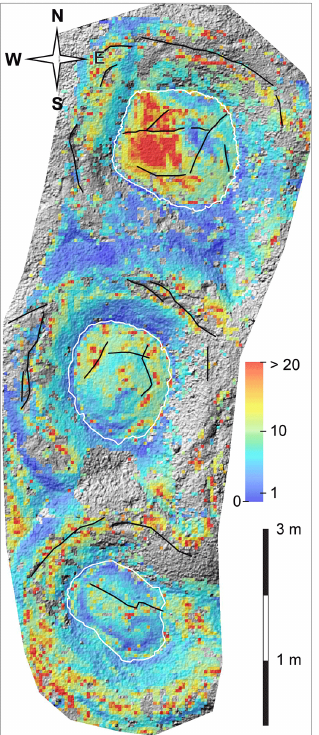
Figure A3. Ratio between displacement magnitude (cmyr − 1 ) and tangent of slope. Typical ratios on the inner slopes of the gravel rings are 1–3; typical ratios on the fine domains and the ring tops are around 7 (green colours); at places ratios of 20 to 50 are found (red colours). Furthermore, would yellow colours not be around 15 or so? It is not clear what the relation to 7 is. Please make this clearer. The data illustrate the low correlation between slope and displace- ment magnitude on the circles.